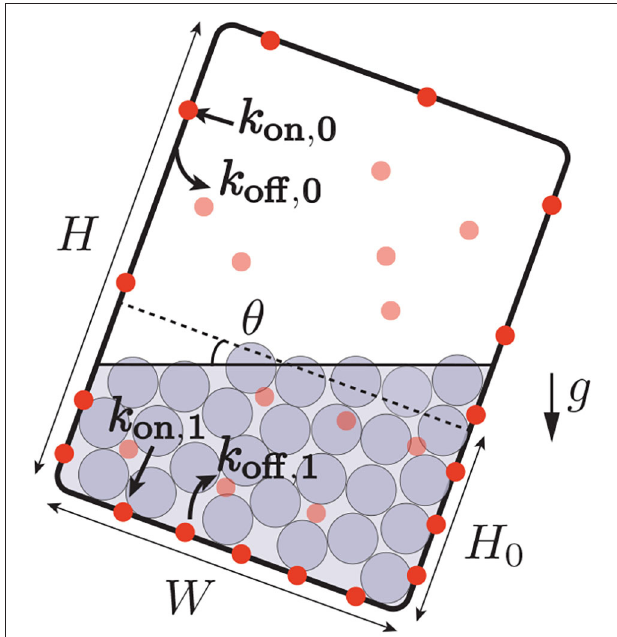
FIGURE 3 | Interaction between PIN trafficking and statoliths position. The rate of reallocation k on and deallocation k off of PINs (bold red circles: PINs attached to the cell membrane, light red circles: PINs in bulk) depends on the presence of statoliths (gray). When the cell is tilted, the asymmetric distribution of the position of the statoliths induces a bias in the distribution of the PINs attached to the